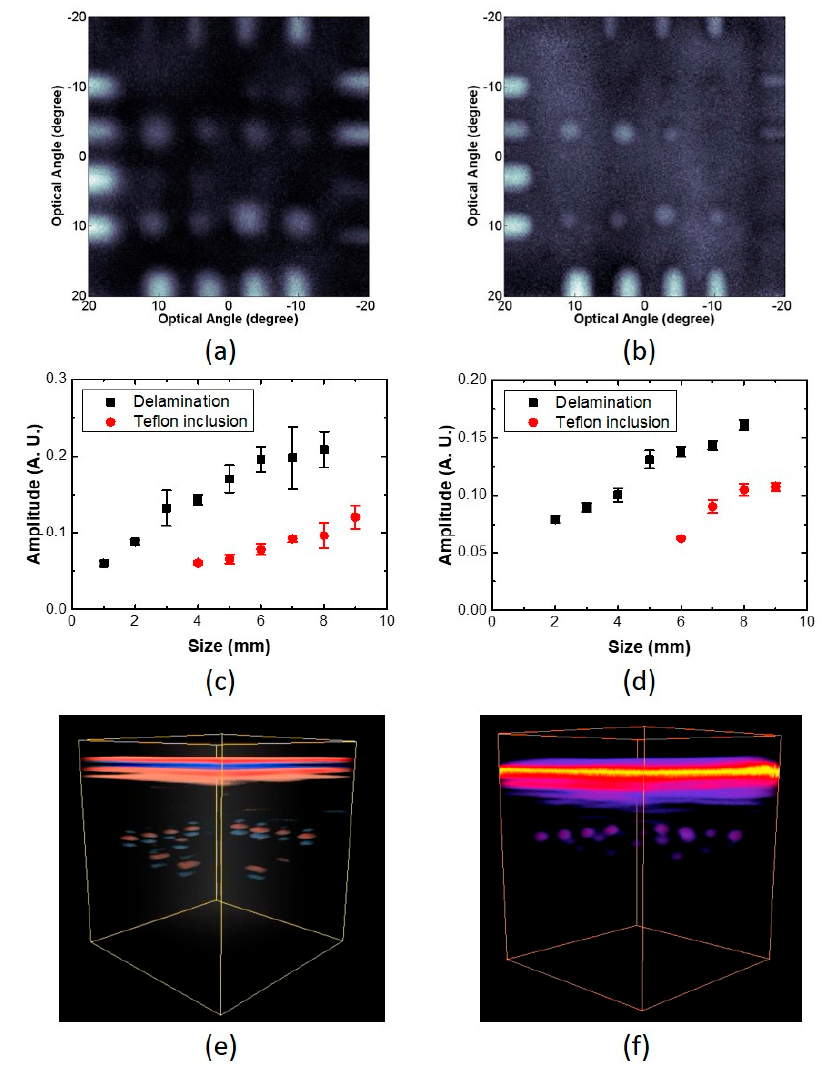
Figure 5. ( a ) C-scan image, ( c ) THz signal amplitude versus defect size, and ( e ) 3D image of sam- ple B obtained using the time-domain THz tomography system. ( b ) C-scan image, ( d ) THz signal amplitude versus defect size, and ( f ) 3D image of sample B obtained using the frequency-domain THz tomography system.